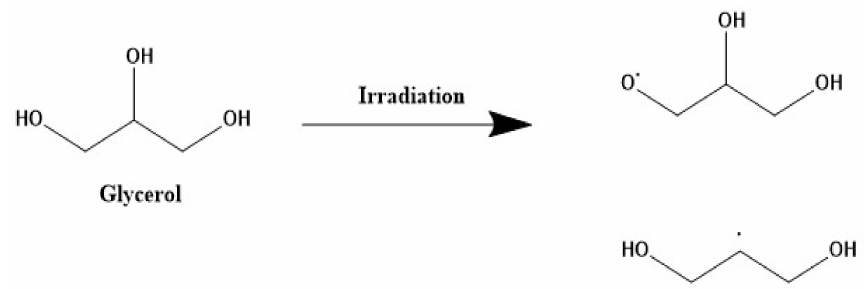
Figure 3. Represent the free radicals of